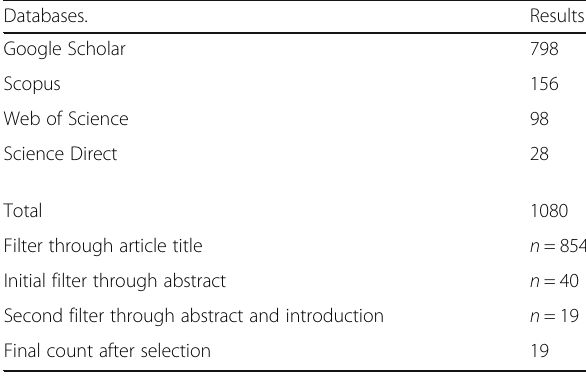
Table 4 Climate adaptation results Databases.